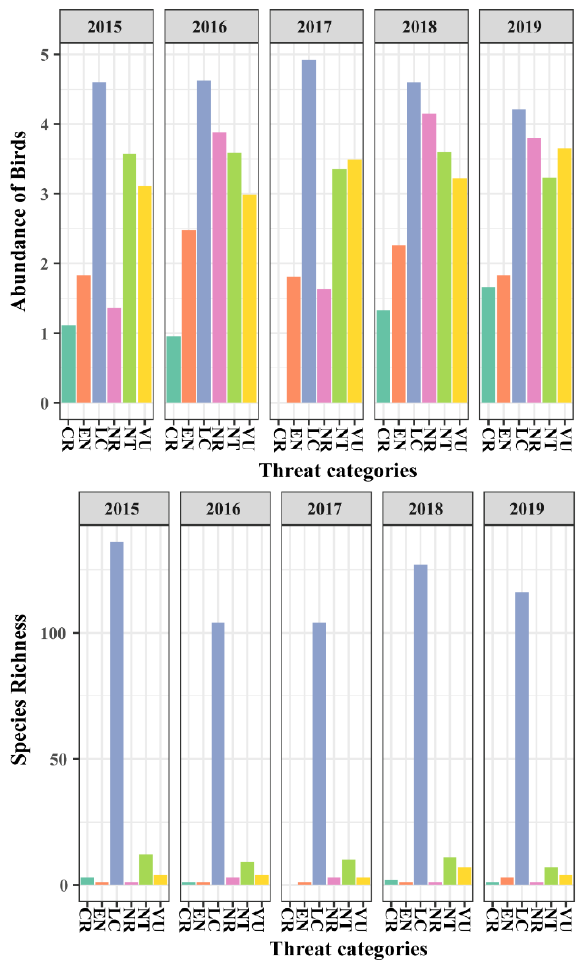
Figure 4. Annual abundance of birds and species richness sorted by threat categories. Data for abundance of birds were presented in logarithmic form. CR: critically endangered; EN: endangered; LC: least concern; NR: not recognized; NT: near threatened; VU: